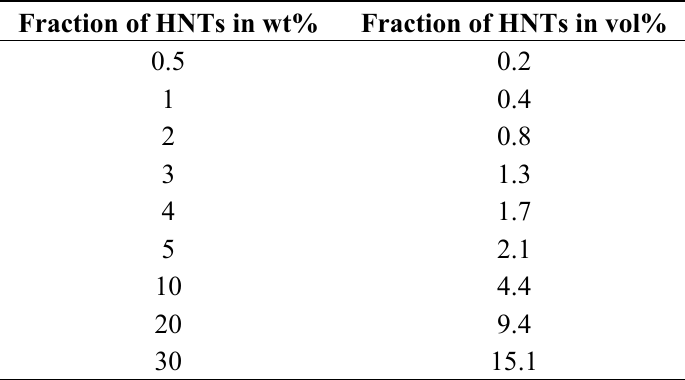
Table 1. Halloysite nanotubes (HNT) fractions in wt% and vol%.